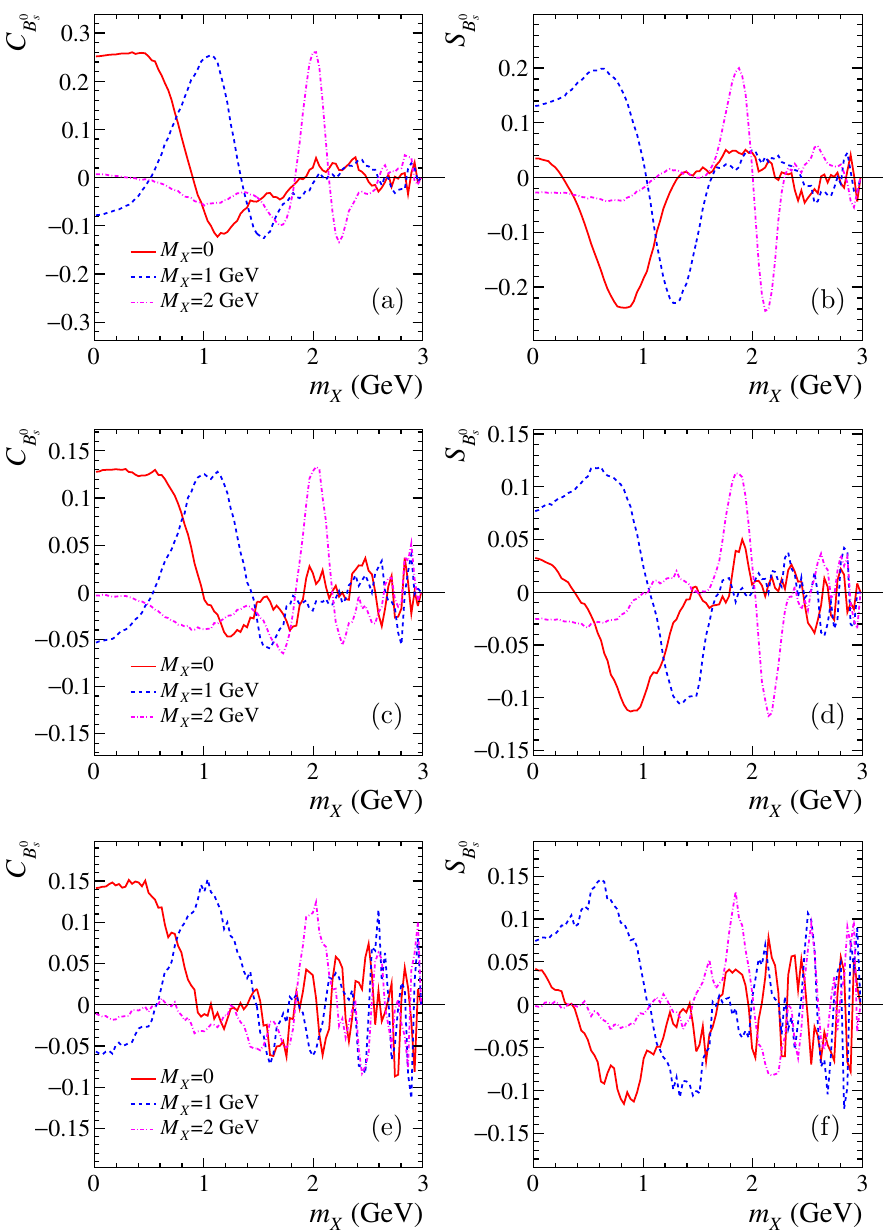
Figure 7 . (a,c,e) Real C and (b,d,f) imaginary S parts of the amplitude of the harmonic B 0 s B 0 s corresponding to B 0 oscillation frequency (cid:1) m s as a function of assigned mass m X for three values s of the true mass M X , for (a,b) vertex resolution components (cid:27) x = 20 (cid:22) m, (cid:27) z = 0 and 10 5 events of each B 0 (cid:13)avour, (c,d) (cid:27) x = 40 (cid:22) m, (cid:27) z = 0 and 10 5 events of each B 0 (cid:13)avour, and (e,f) (cid:27) x = 40 (cid:22) m, s s (cid:27) z = 300 (cid:22) m and 10 4 events of each B 0 (cid:13)avour. s